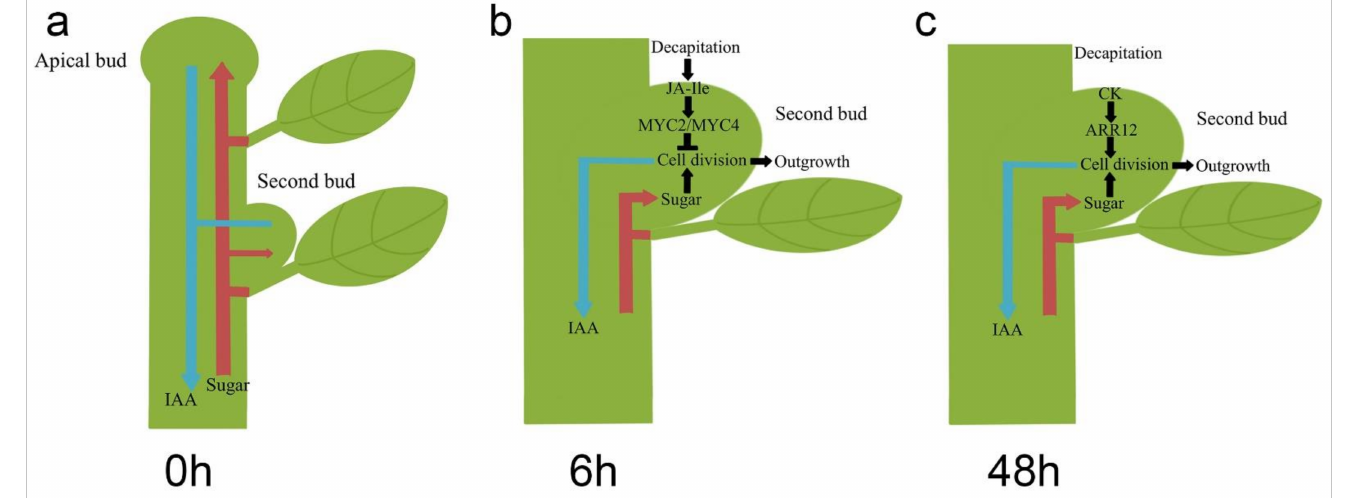
Figure 5. Models of second bud outgrowth after decapitation at 0 h ( a ), 6 h ( b ), and 48 h ( c ). Supplementary Materials: The following are available online at https://www.mdpi.com/article/10 .3390/biology10050440/s1, Table S1: List of predicted alternative splicing events, Table S2: List of transcripts identified as lncRNAs, Table S3: Target mRNAs predicted to interact with lncRNAs, Table S4: Functional annotation of transcripts in F01 cDNA libraries, Figure S1. Venn diagram showing the identification of lncRNAs (a) and the classification of 2,835 TFs in F01 libraries (b), Figure S2. GO annotations in the ‘0 h vs 6 h’ and ‘6 h vs 48 h’ comparisons. (a) GO annotations in the ‘0 h vs 6 h’ comparison; (b) GO annotations in the ‘6 h vs 48 h’